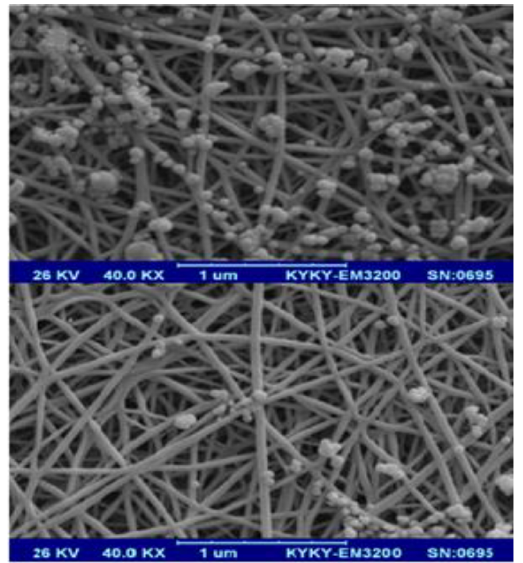
Fig. 3. SEM images of PVA nanofibers in the concentration of 10%w/v containing 0.01g MNPs and 3.5%wt. DOX